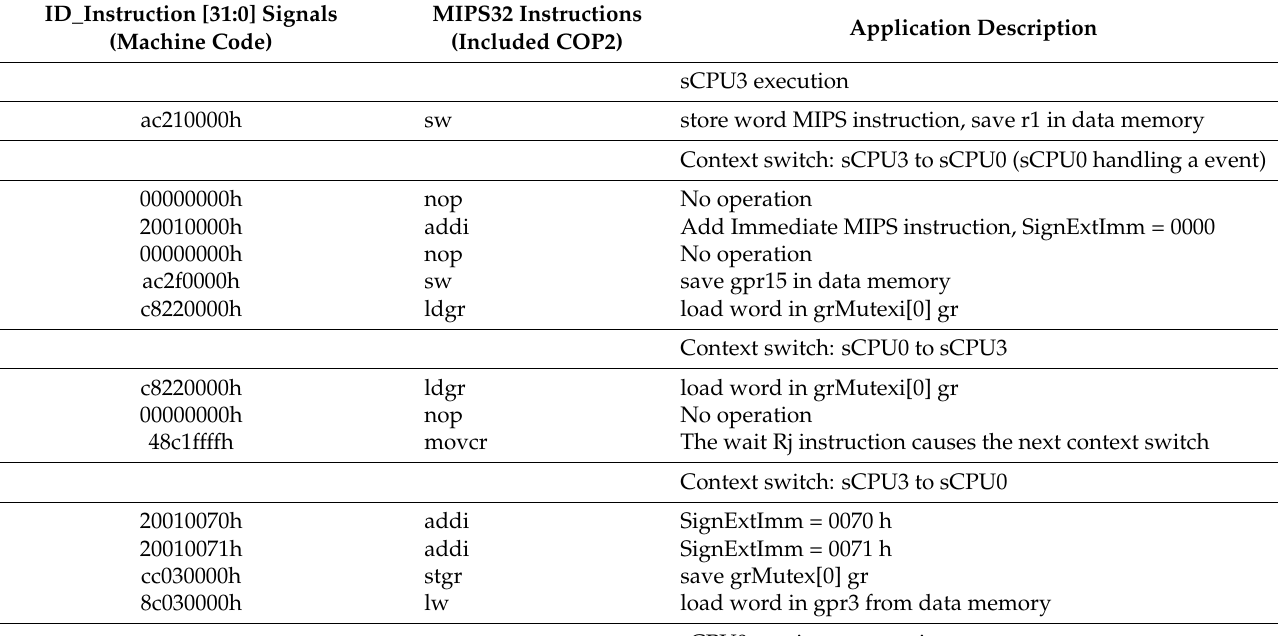
Table 1. The application sequence to validate a mutex event generated by the release of mutex grMutexi[0] (sCPU0 and